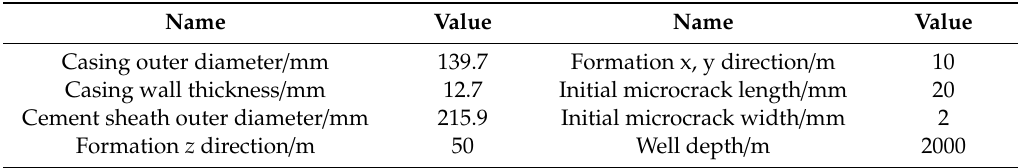
Table 1. The dimensions of each parts in the models.